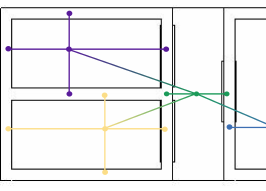
Figure 12. Clusters found in the vector subspace embedding for G (green) and H